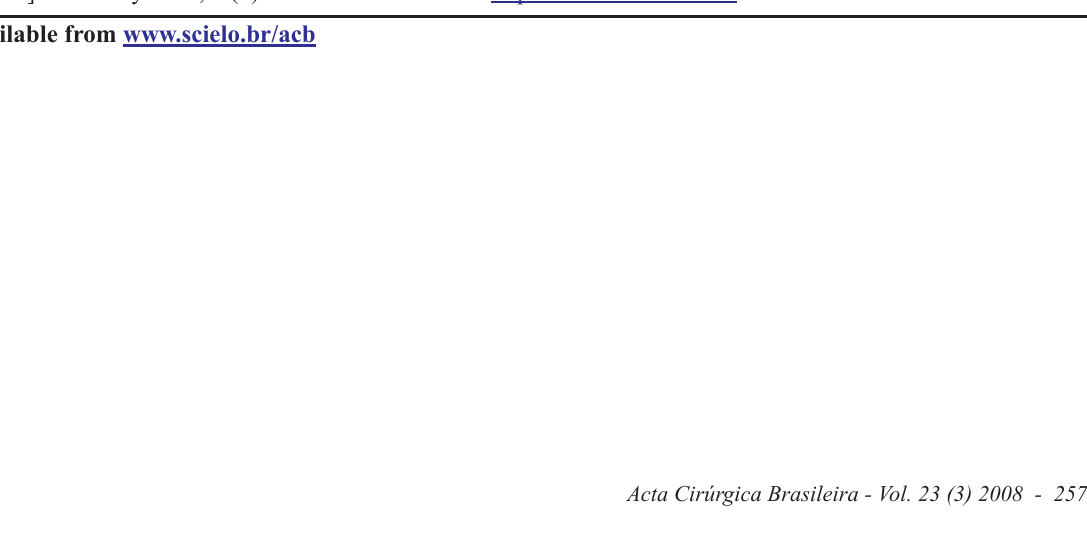
*Color figure available from